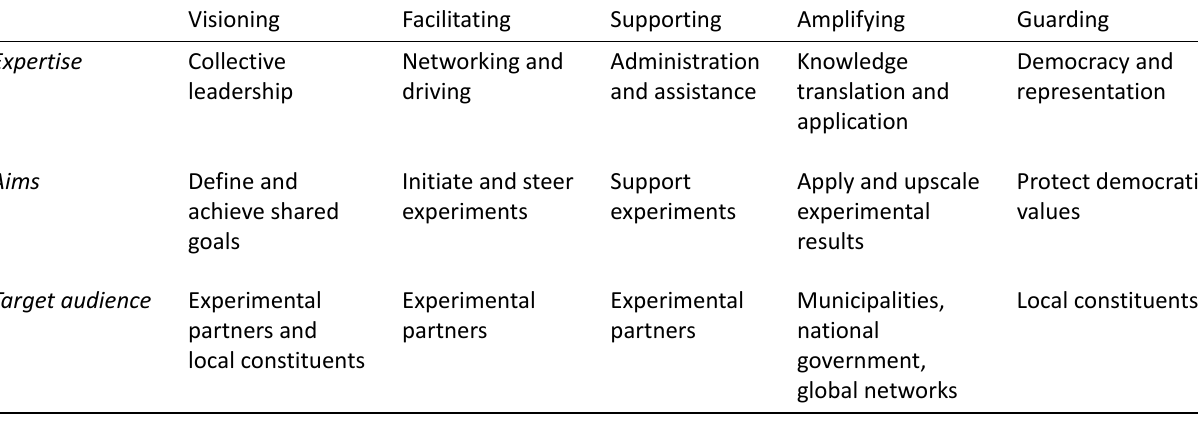
Table 1. Five strategic functions of municipalities in experimental governance.